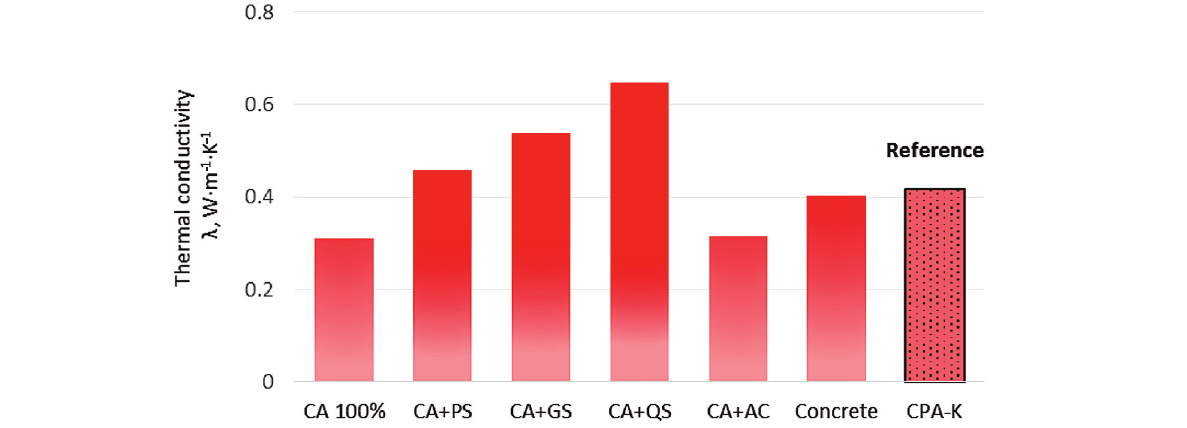
Fig. 8. Thermal conductivity of CA-based materials. Table 2. Thermal conductivity and density of different compositions compared to the reference